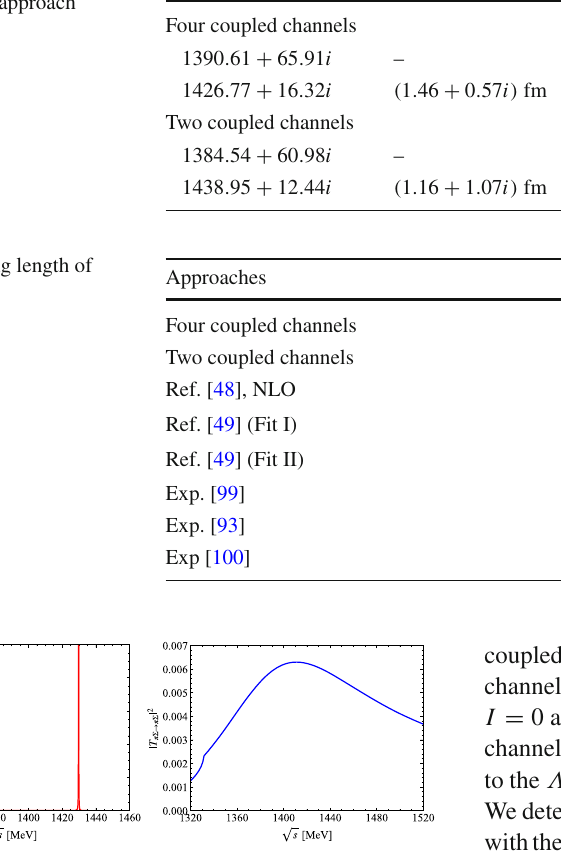
Table 4 Radii of the poles evaluated with Eq. (17) in coupled channels approach